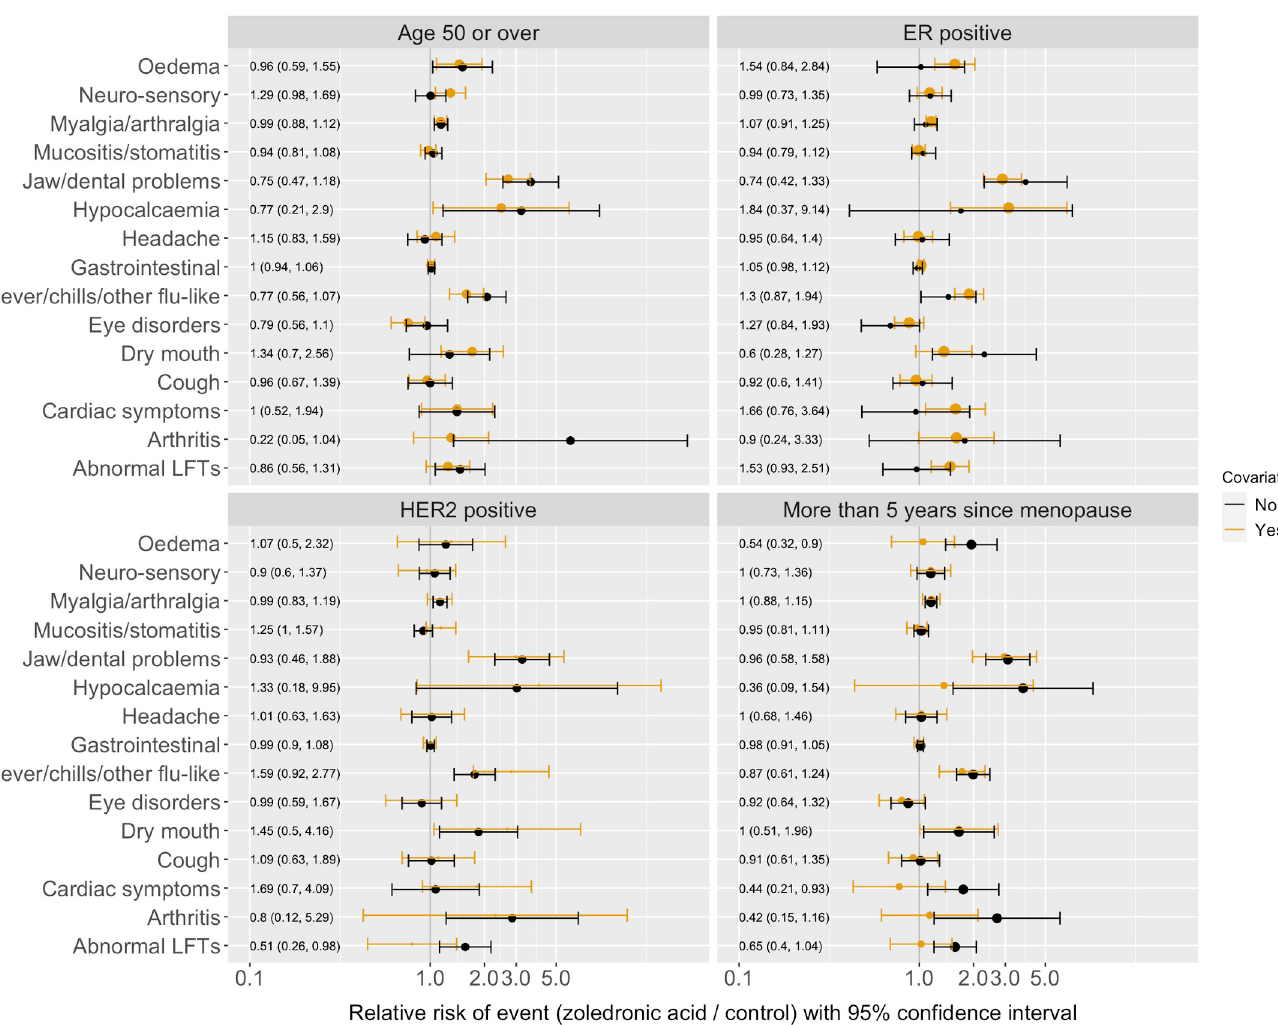
Fig 3. Subgroup analyses of the individual patient data from AZURE. Shows: The relative risk of each side-effect (bisphosphonates versus control) if they were in the indicated subgroup (yellow) or not (black). Separation between the yellow and black intervals indicates how much the covariate modifies the treatment